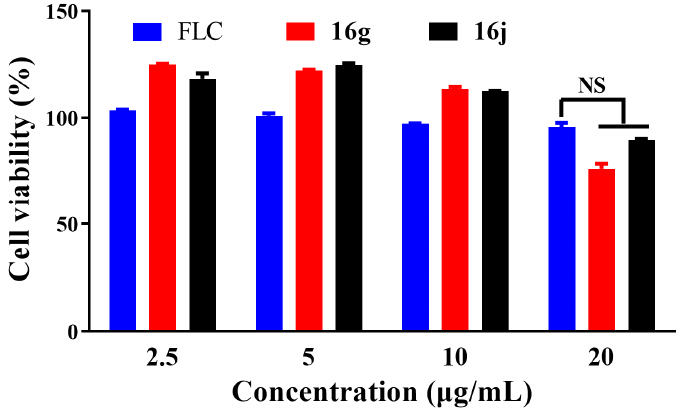
Figure 2. The in vitro toxicity evaluation of 16g , 16j and FLC. The cytotoxic effects of compounds 16g and 16j , compared to that of FLC, on HUVECs viability was assessed by the CCK-8 test following a 2 h treatment. FLC: fluconazole.